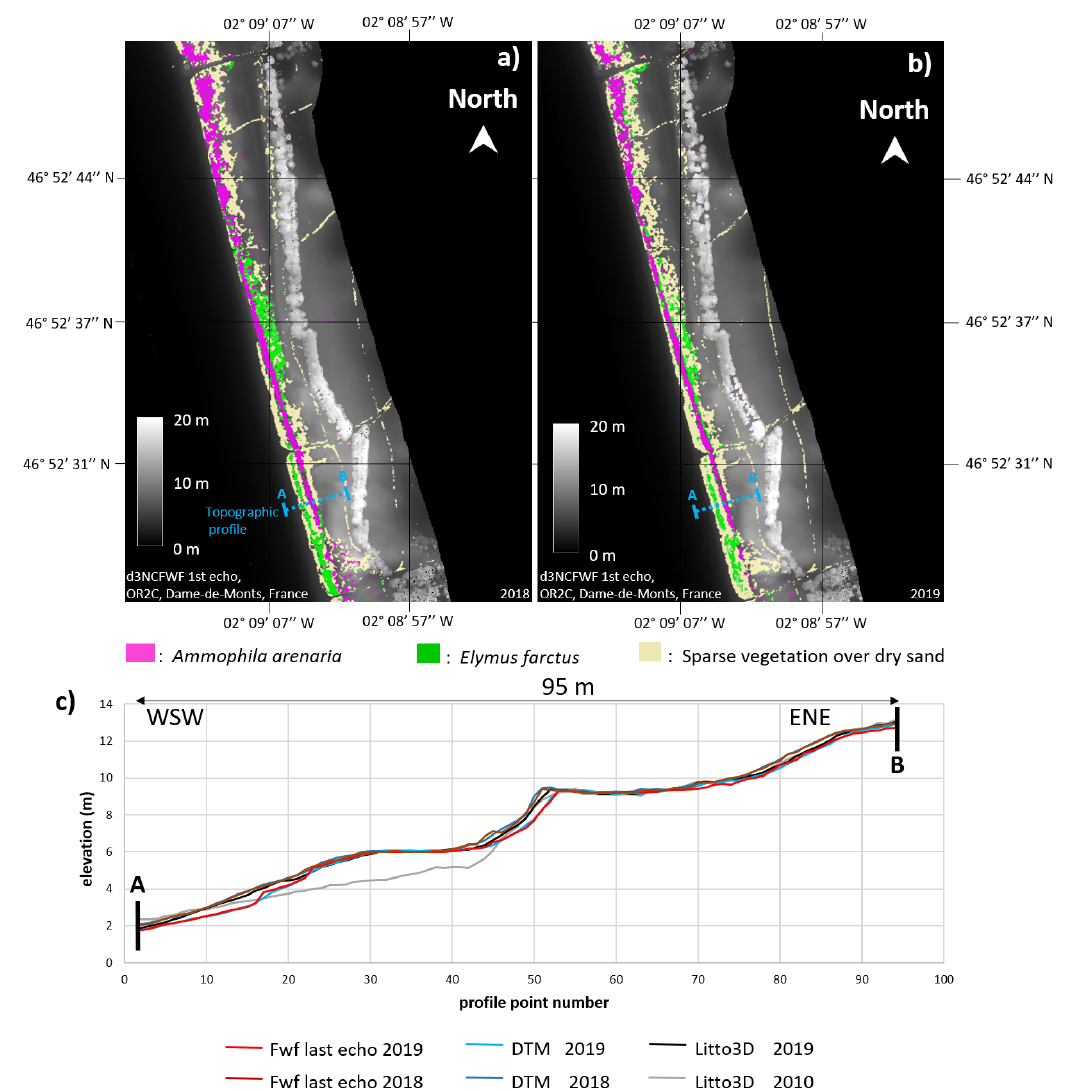
Figure 15. Notre-Dame-de-Monts validation area with the same caption as Figure 13. See location b in Figure